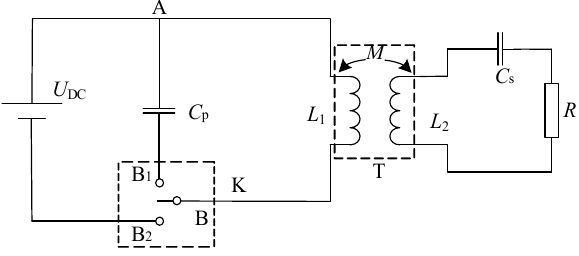
Figure 1. The conceptual schematic of the IIEIFR system.